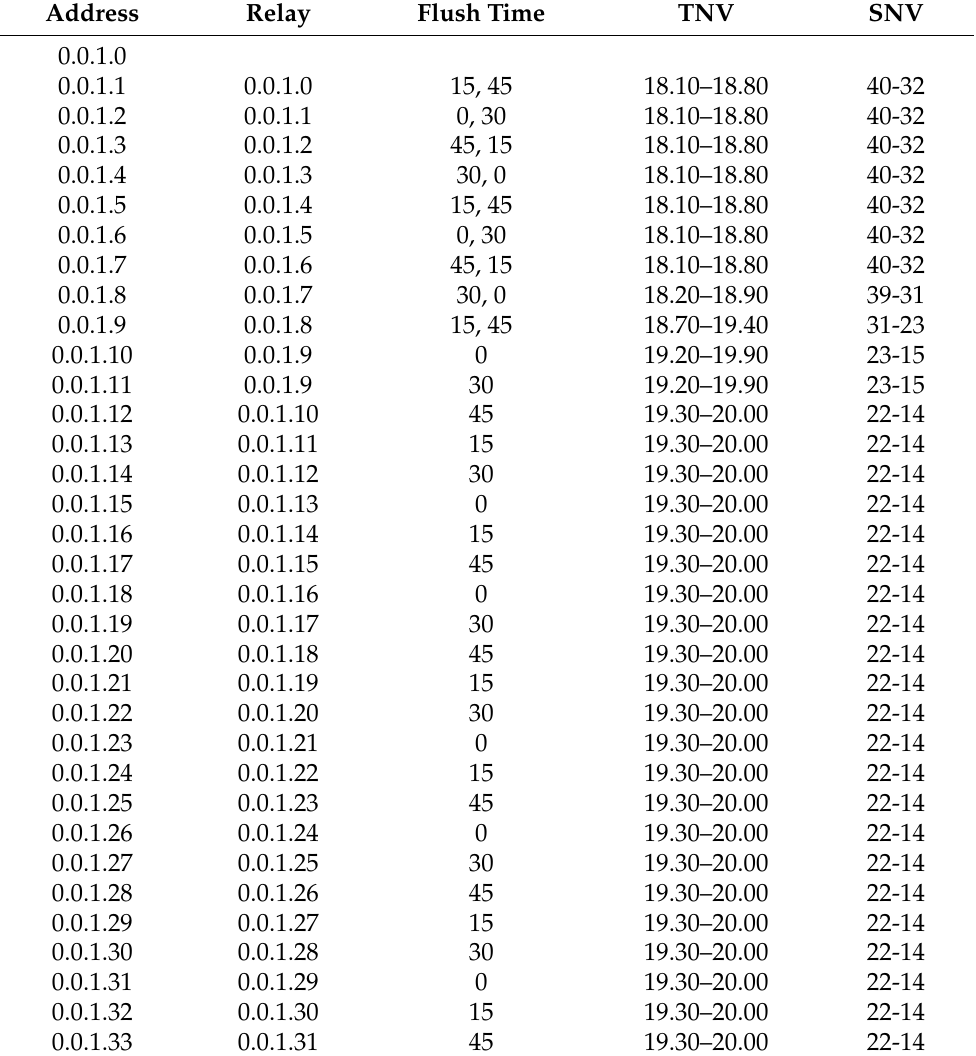
Table 2. Node’s scheduled